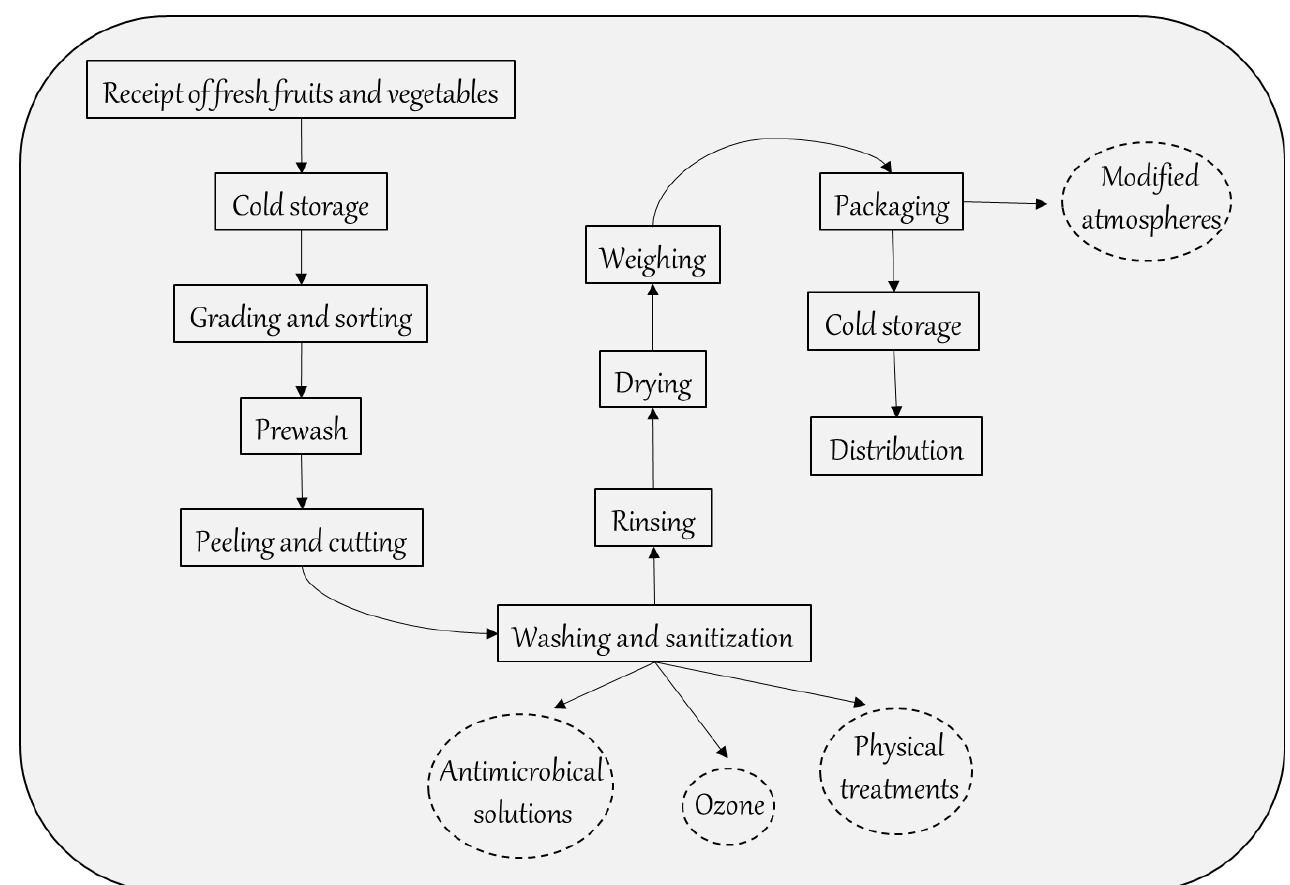
Figure 1. Flow sheet of cut fruit and vegetable products .